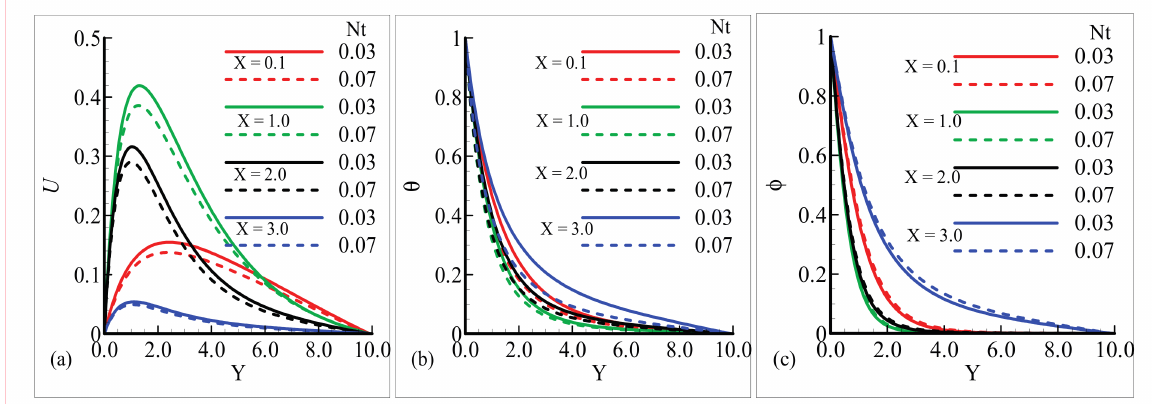
Figure 7. Physical e ff ects on quantities ( a ) U , ( b ) θ , and ( c ) ϕ versus Nt, when Sc = 1, Nb = 0.4, pr = 7.0, M = 0.2, Q = 1.0.